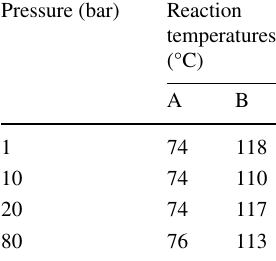
inflexion points of TPD curves of LiNH 2 BH 3 at different pressures (Fig. 2)